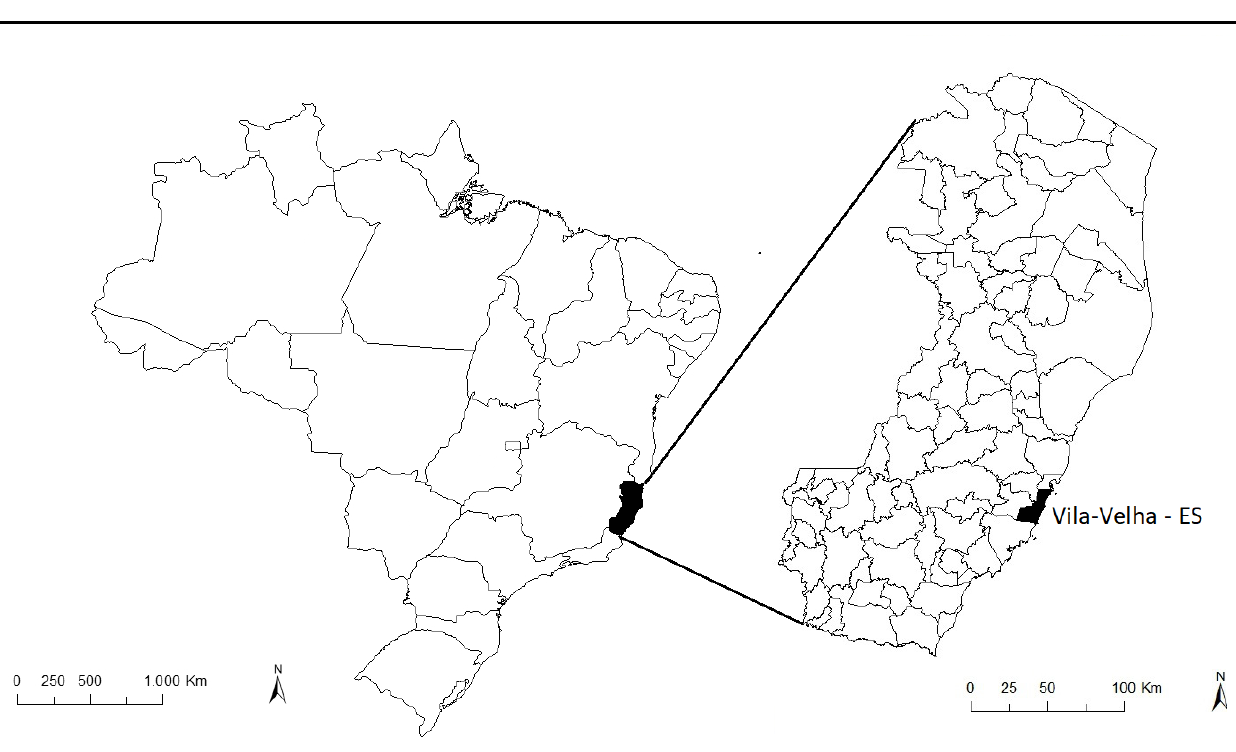
FIGURE 1 – Map of Brazil with emphasis on the Espirito Santo state and VilaVelha city, where the study was conducted. This map was drawn from the cartographic base of IBGE (Instituto Brasileiro de Geografia e Estatística) available in https://mapas.